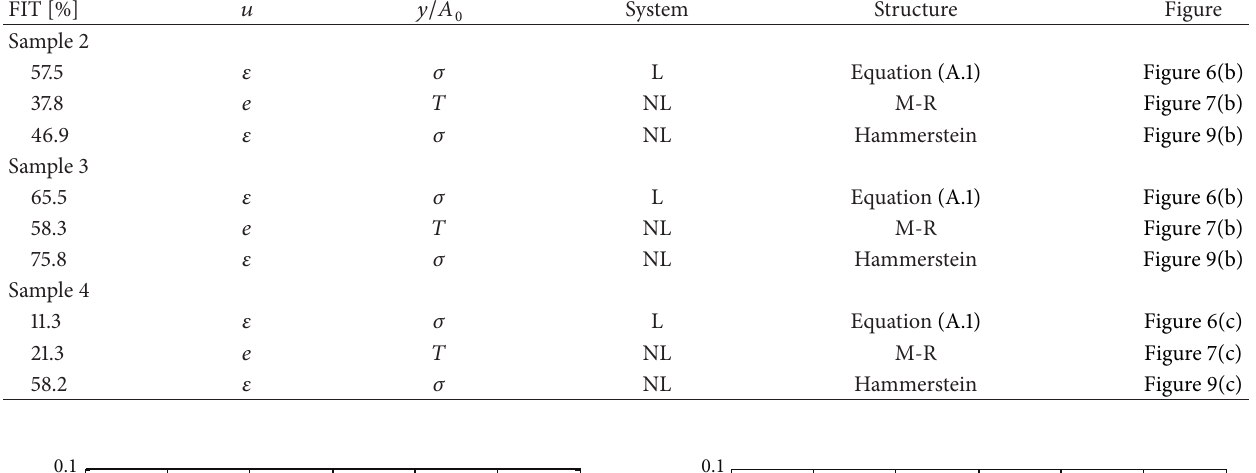
Table 2: FIT parameters of the identified model obtained with the validation data (samples 2, 3, and 4). The methods and algorithms are also detailed. The validation data are referenced to the corresponding figure. M-R, L, and NL mean Mooney-Rivlin, linear and nonlinear.